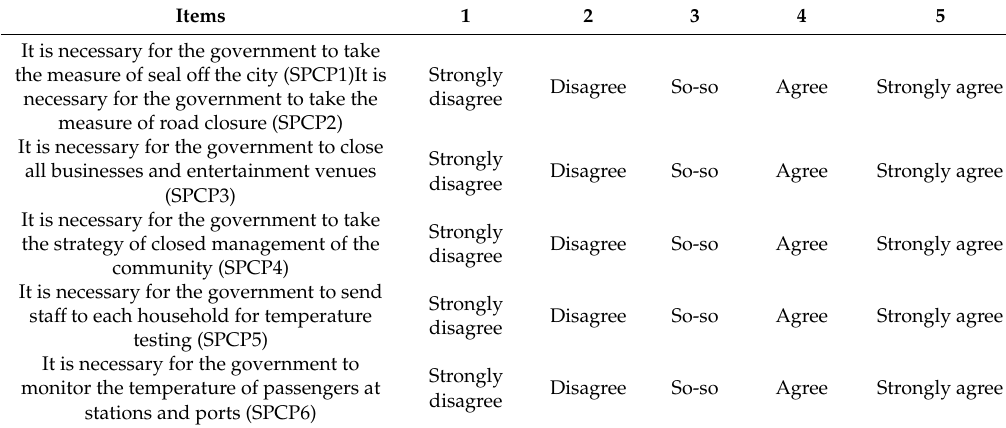
Table A5. Scale to measure support for prevention and control